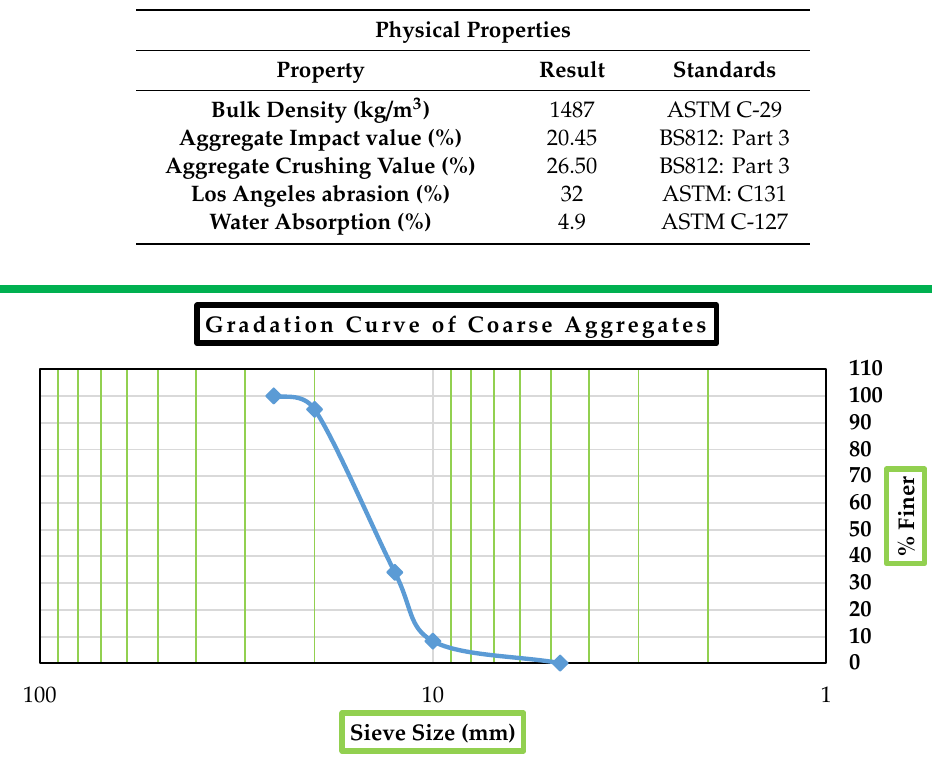
Figure 2. Grain size distribution (sieve) analysis of coarse aggregate.